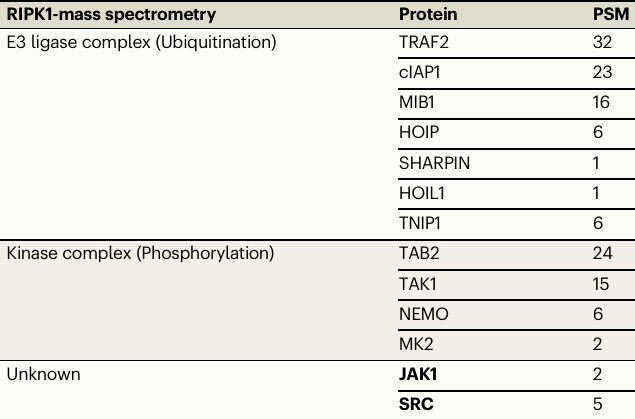
Table 1 | Identi fi cation of RIPK1 interacting proteins via